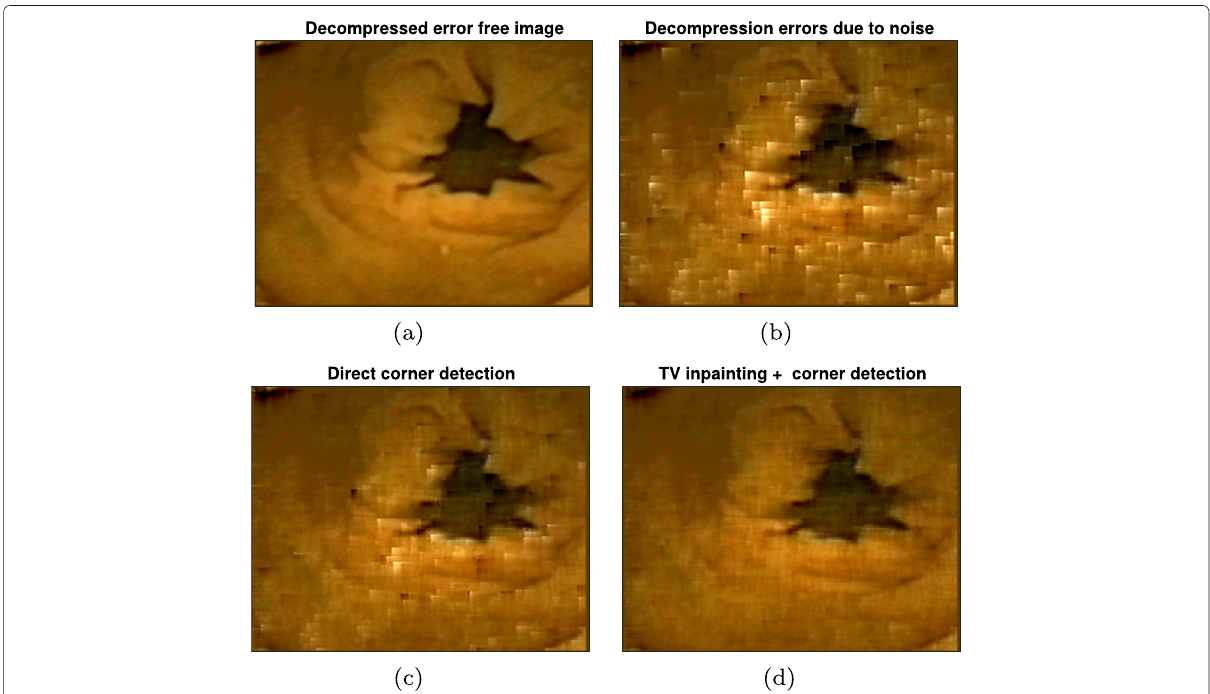
Fig. 4 a Decompressed WCE image. SSIM w.r.t. original in Fig. 2a is = 0.8. b Decompressed image with errors. SSIM = 0.75 c Corrected with corner detection. SSIM = 0.76. d Corrected with TV inpainting (compression domain) and corner detection. SSIM = 0.86